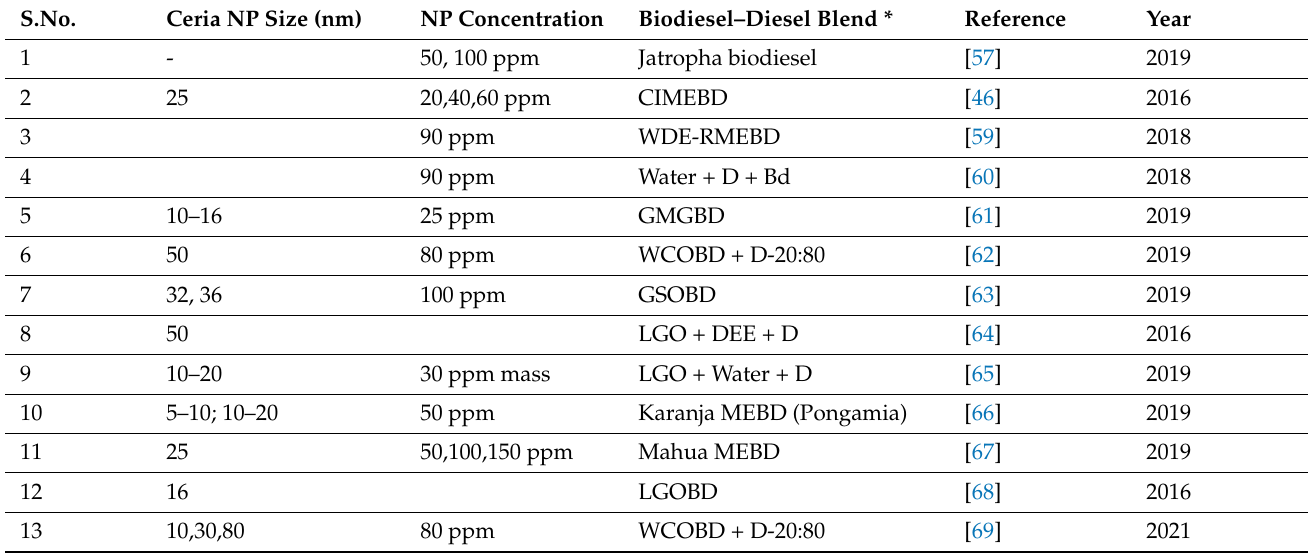
Table 2. Summary of investigations using pure (unmixed) CeO 2 NPs with relevant details; —indicates that the values are not